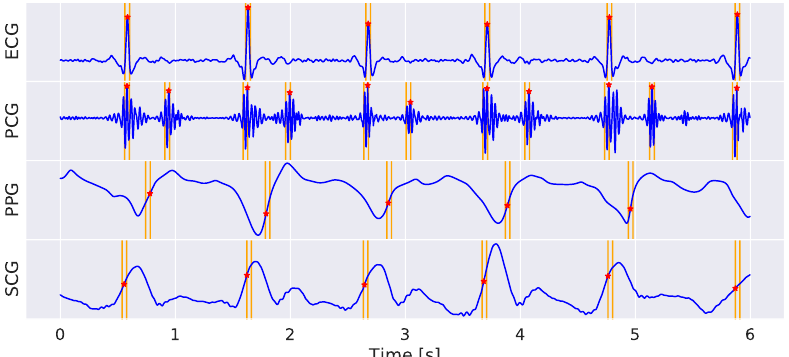
Figure 9. Example of a 6 s acquisition with superimposed eMTUnet predicted segmentation land- marks. The network classified this example as class 1 with a CS score equal to